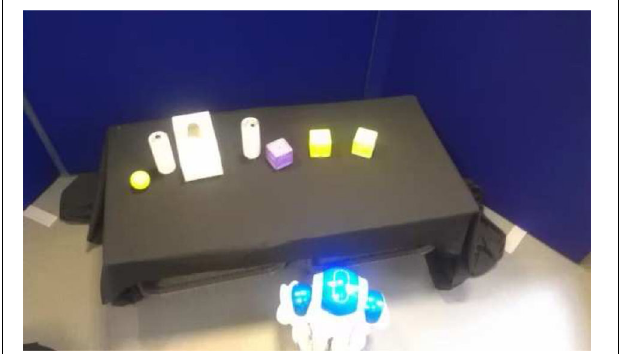
FIGURE 5 | The simpler environment used in the initial tests of the robot